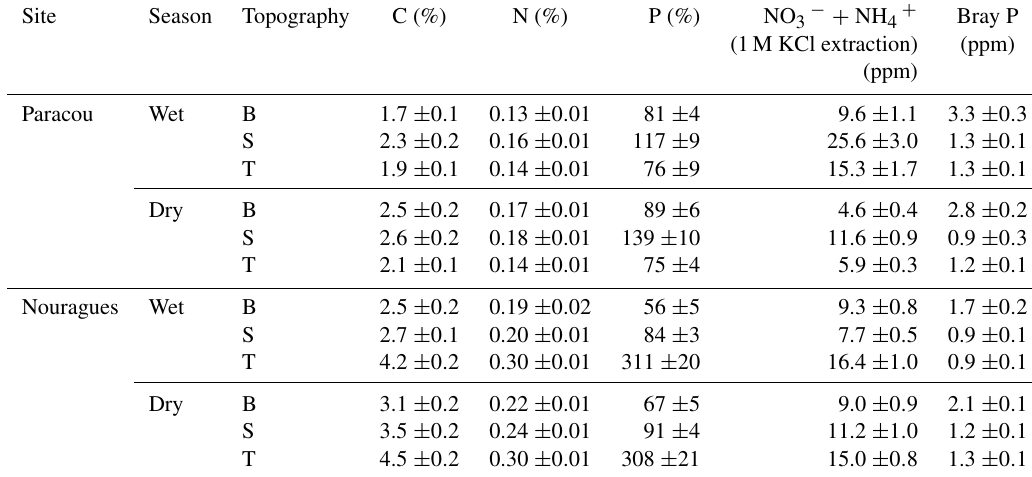
Figure 1. Situational map: (a) northeastern part of South America, (b) northern French Guiana with its main cities (circles) and the exper- imental sites of Paracou and Nouragues (closed squares), (c) the twelve 50 × 50m plots of this study at Nouragues–Inselberg, and (d) the twelve 50 × 50m plots of this study at Paracou. Adapted from Ferry et al. (2010) and Courtois et al. (2018). Plots are marked by a letter describing the topography (B = bottom, S = slope, T = top) and a number describing the nutrient addition treatment (1 = + N, 2 = + NP, 3 = + P, 4 = control). Table 1. Surface soil (0–15cm) total and available nutrient concentrations measured in 2015 in the three landscape positions (topography: B = bottom, S = slope, T = top) and separated by season. Standard errors are shown ( n = 20). Site Season Topography C (%) N (%) P (%) NO 3 − + NH 4 + Bray